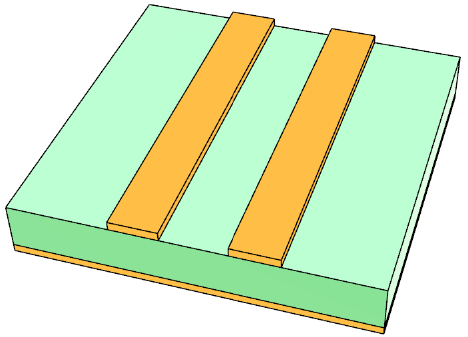
Figure 1. A perspective view of a conventional DL.